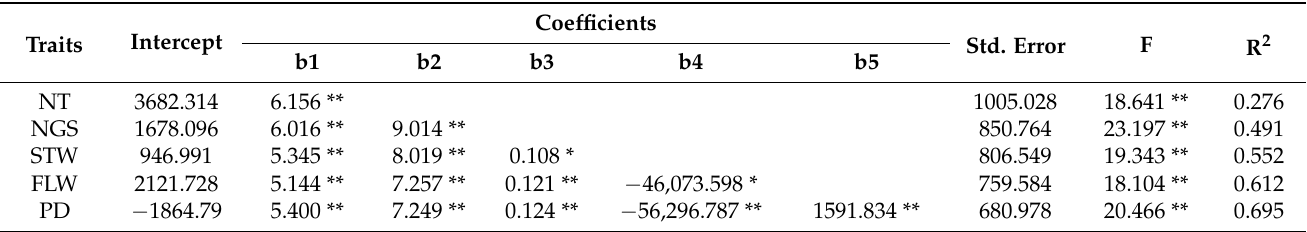
Table 2. Results of stepwise regression of grain yield per hectare as a dependent variable and other traits as the independent variables in the F8 population resulting from Gonbad × Zagros in 2021.